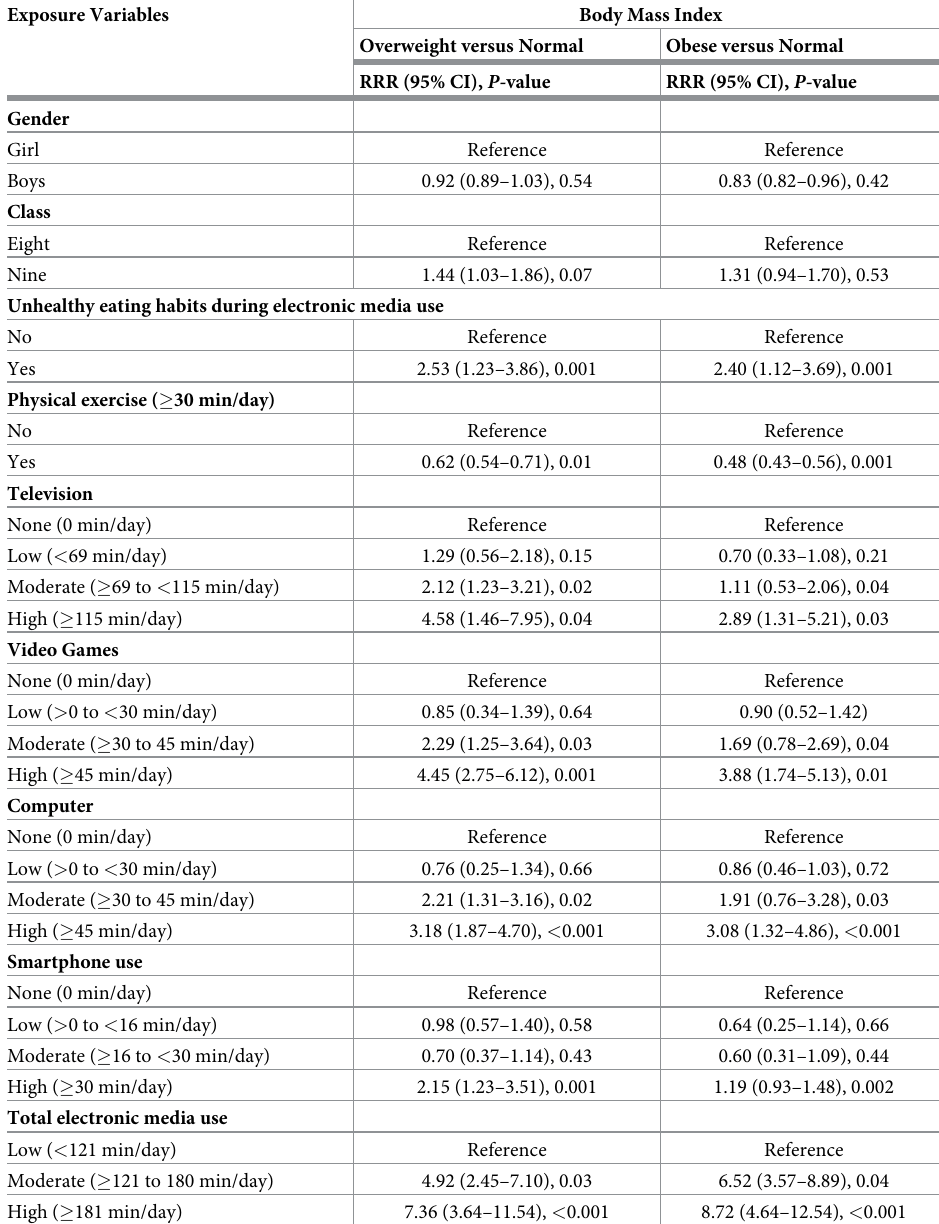
Table 3. Multinomial logistic regression for the association between electronic media use with BMI. Exposure